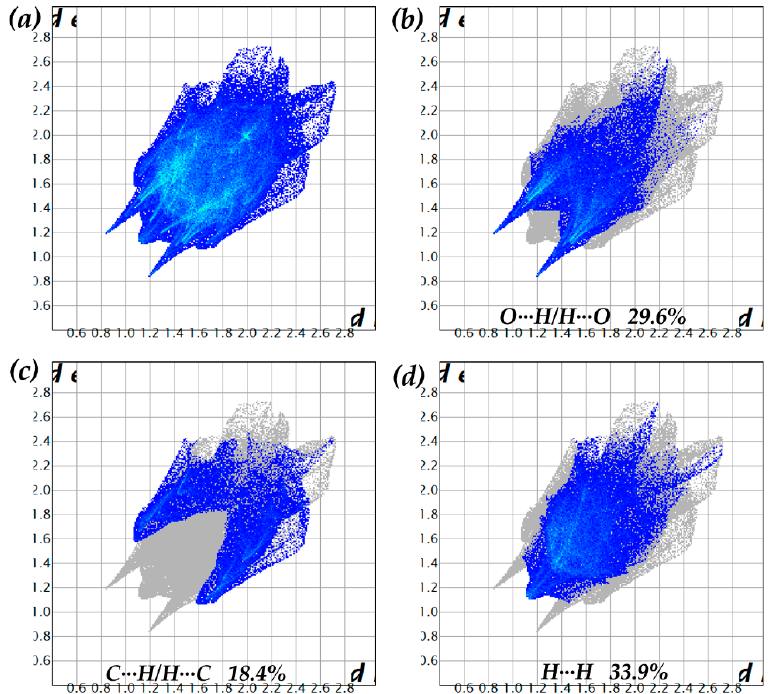
Figure 6. Fingerprint plots: Full ( a ) and resolved into O ··· H/H ··· O ( b ); C ··· H/H ··· C ( c ) and H ··· H ( d ) interactions showing percentages of contacts (more than 5%) to the total Hirshfeld surface area of the molecules.